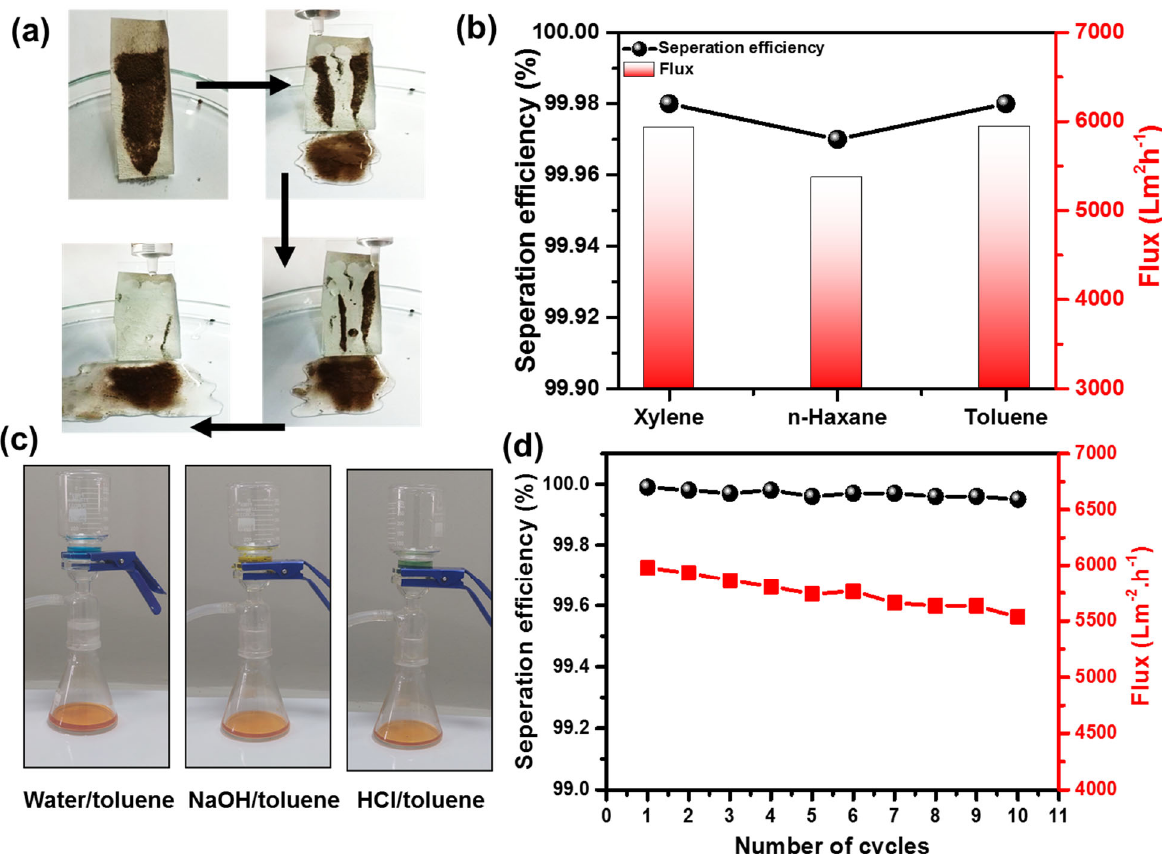
Figure 9 . ( a ) Photographic view of the self − cleaning activity of SiO 2 @PU − NFs membrane; ( b ) water/oil separation e ffi ciency and fl ux, using di ff erent Xylene, n − Haxane, and Toulene as non − aqueous liquids; ( c ) photographic view of toluene recovery from other liquids, such as water, alkali, and acid; ( d ) water/oil separation performance of composite nano fi brous membrane under multiple cycles.